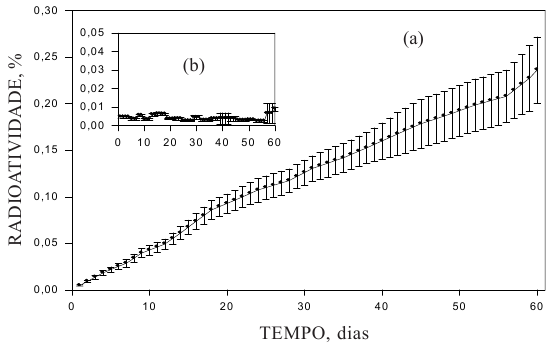
Figura 4. Percentagem de 14 CO degradação da atrazina nos 60 dias de experimento (média dos 4 microcosmos) (a = % acumulada, b = % diária). As barras verticais indicam o desvio-padrão.